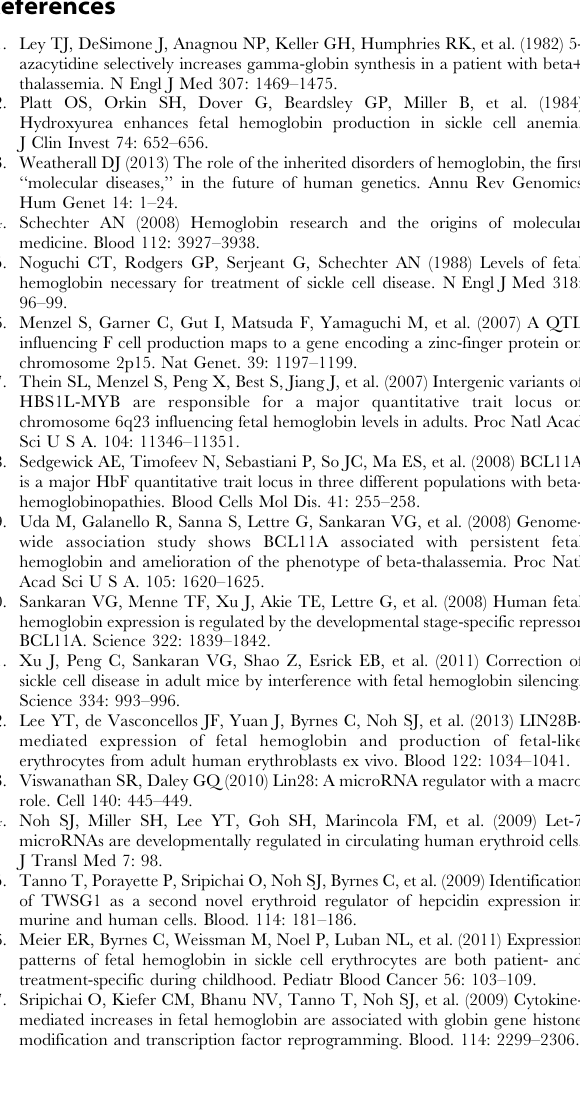
first field from each image corresponds to the representative field shown in Figure 5. Control: empty vector control; LIN28A-OE : LIN28A over-expression. Figure S6 Enucleated erythroid cells from healthy HbAA donor. Representative fields from (A) control (non- transduced cells) and (B) transduced cells. Culture conditions, cell imaging and counting procedures were the same as used for the sickle erythroid cells.